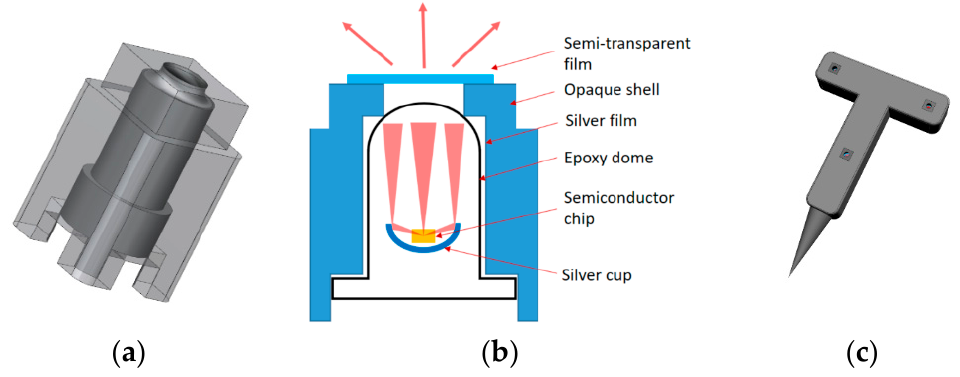
Figure 3. Schematic diagram of an active tool. ( a ) Model diagram of light-emitting diodes (LED) sleeve. ( b ) Active marker schematic. ( c ) Active tool model.